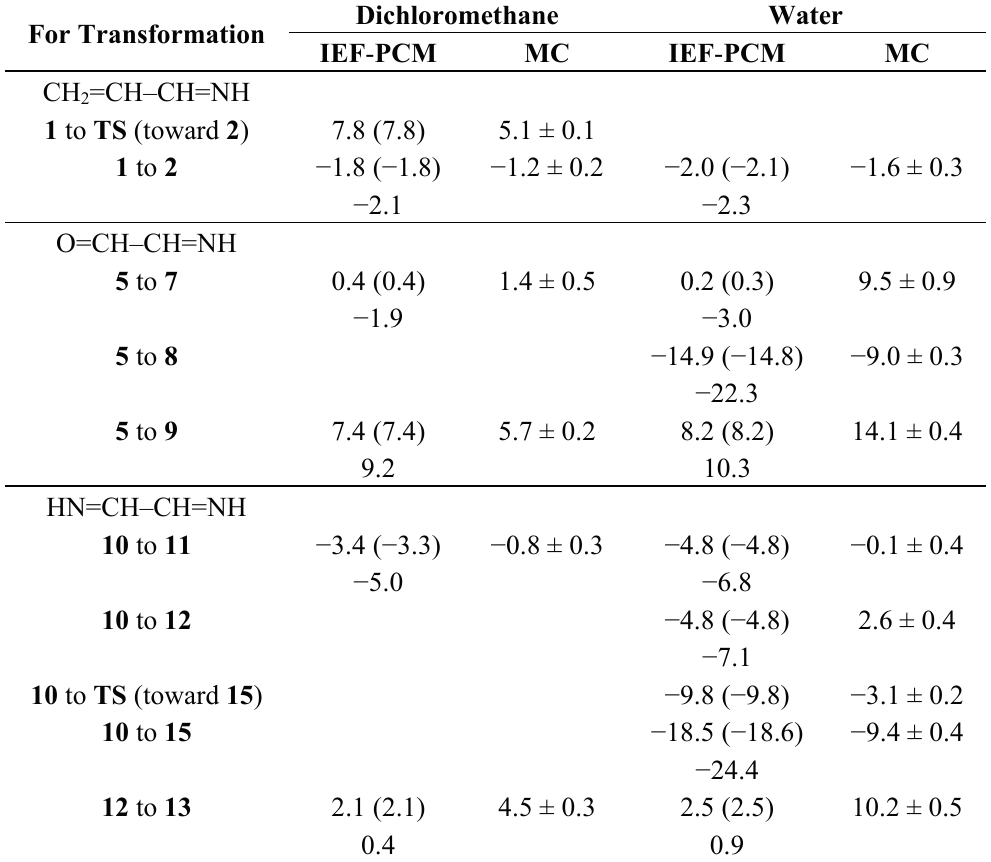
Dichloromethane For Transformation